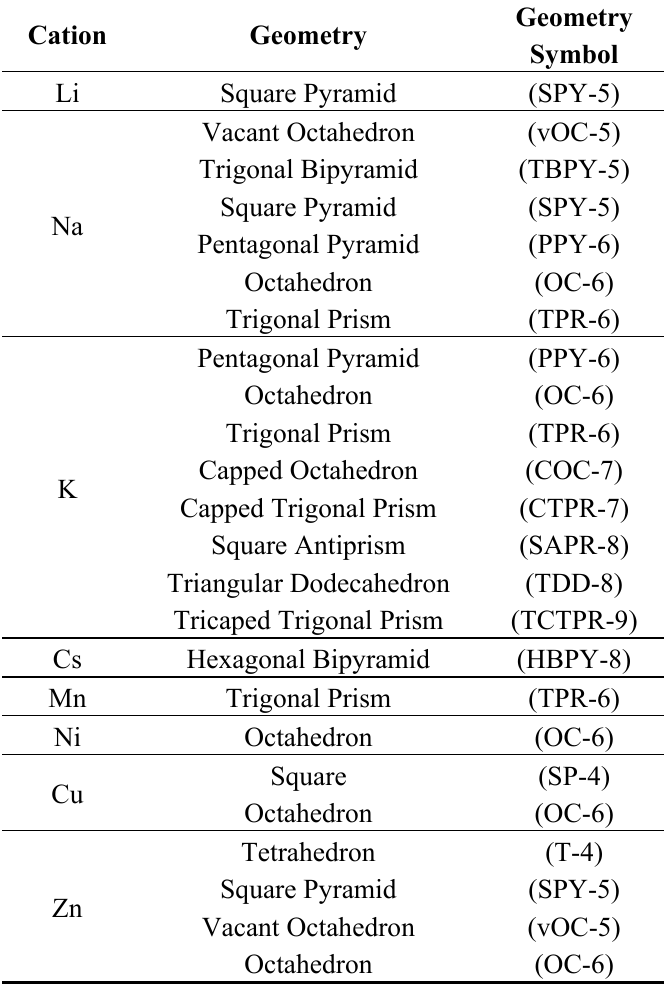
Table 5. List of the best geometries estimated for the alkaline and transition metal ions, using SHAPE